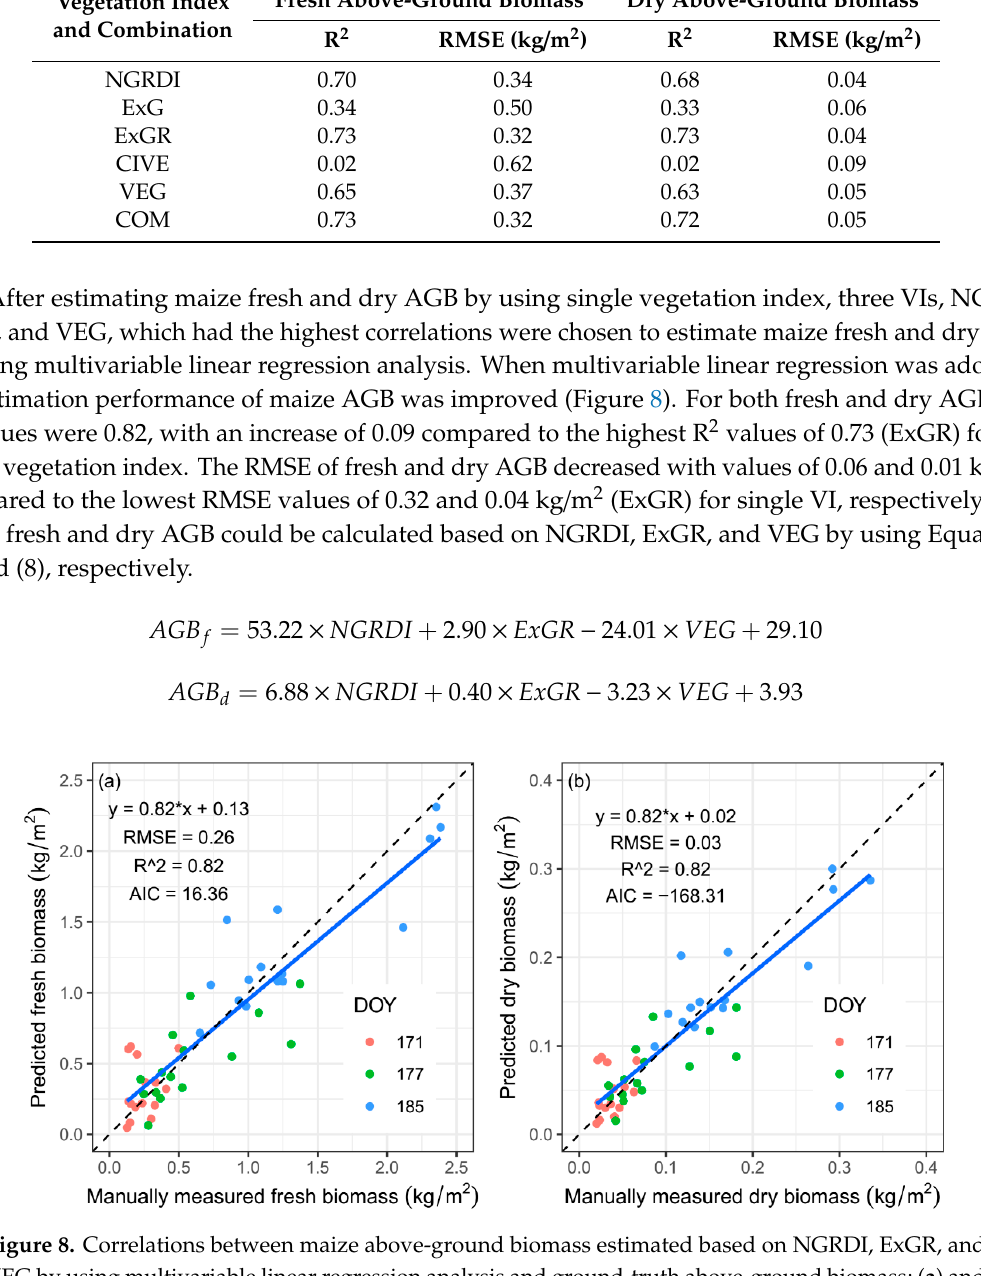
Table 2. Correlations between vegetation indices derived from UAV RGB imagery and ground-truth fresh or dry above-ground biomass. Five vegetation indices and one vegetation index combination, normalized green-red di ff erence index (NGRDI), excess green index (ExG), excess green minus excess red (ExGR), color index of vegetation (CIVE), vegetation index (VEG) and the combination of ExG, ExGR, CIVE, and VEG (COM), were used to establish linear regression estimation models for both maize ground-truth fresh and dry above-ground biomass.